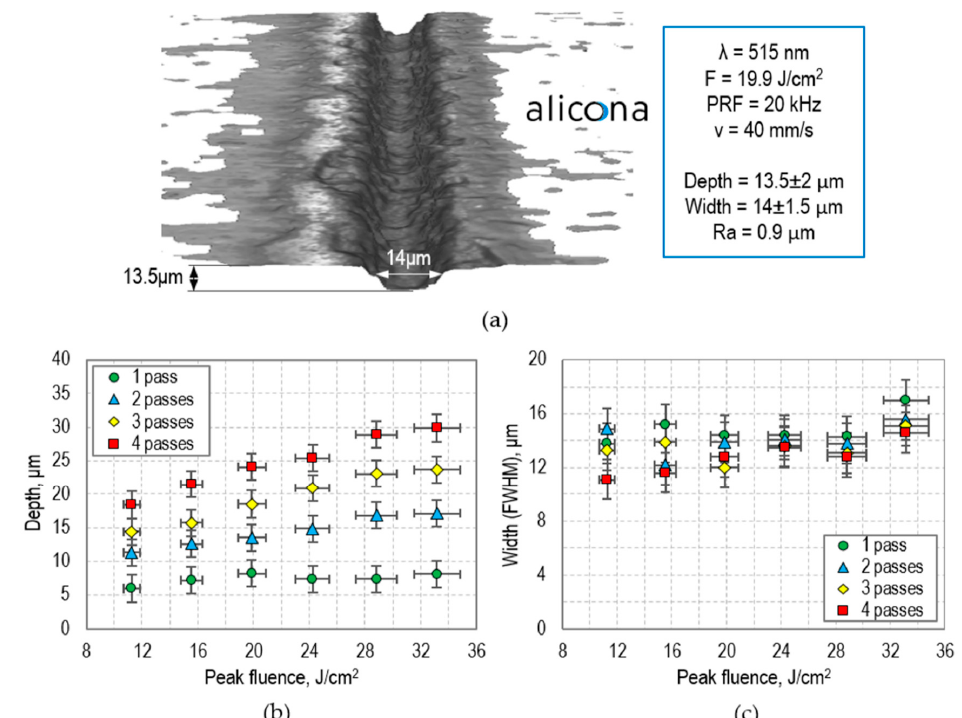
Figure 5. ( a ) 13.5-µm deep and 14-µm wide groove (channel) generated by the picosecond laser